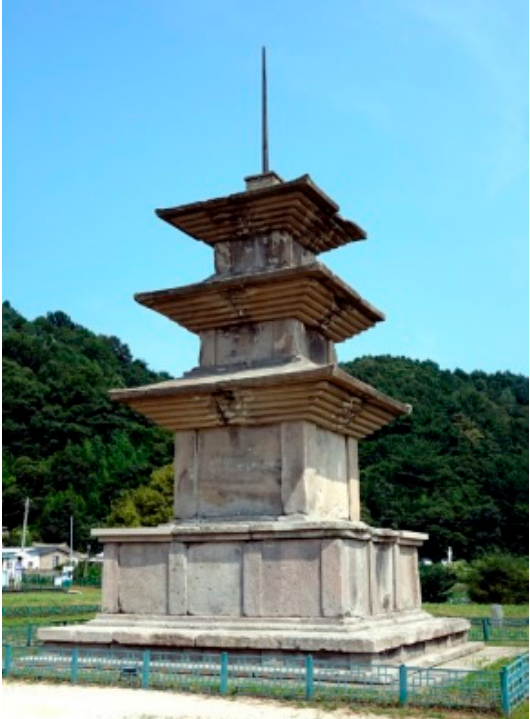
Figure 2. The West Pagoda at the Kam ŭ nsa Temple [©Photograph by Young Jae Kim].